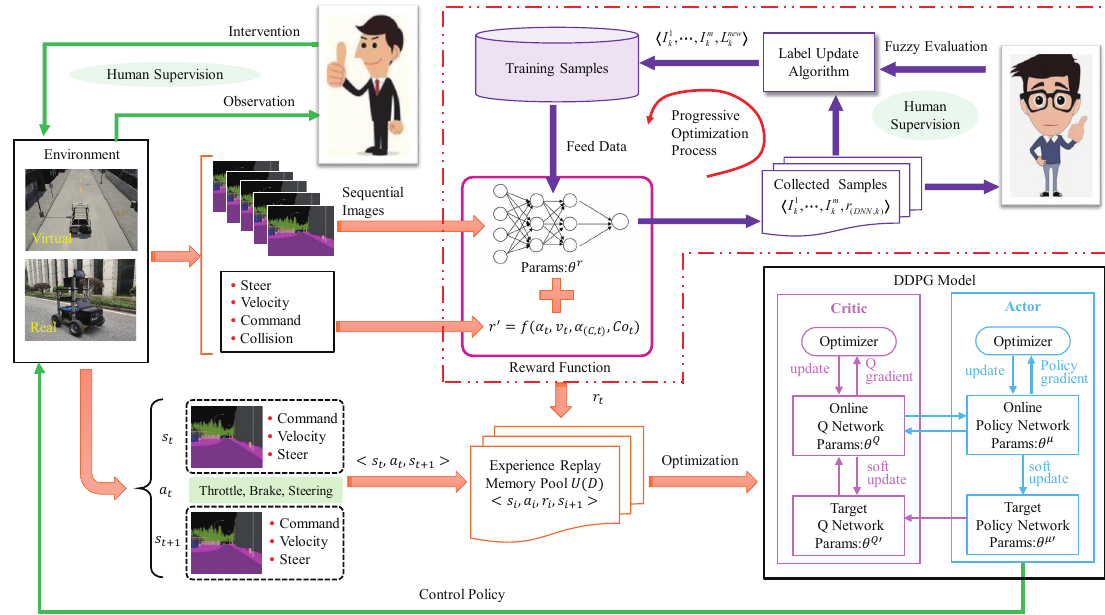
Figure 1. System structure of